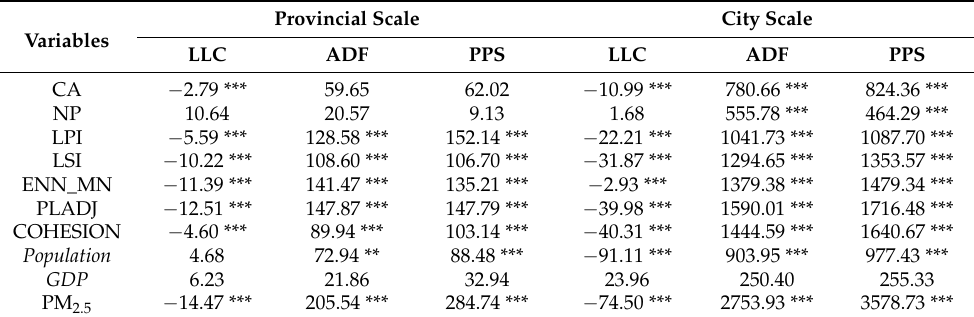
Table 4. Results of the panel unit root tests at the different